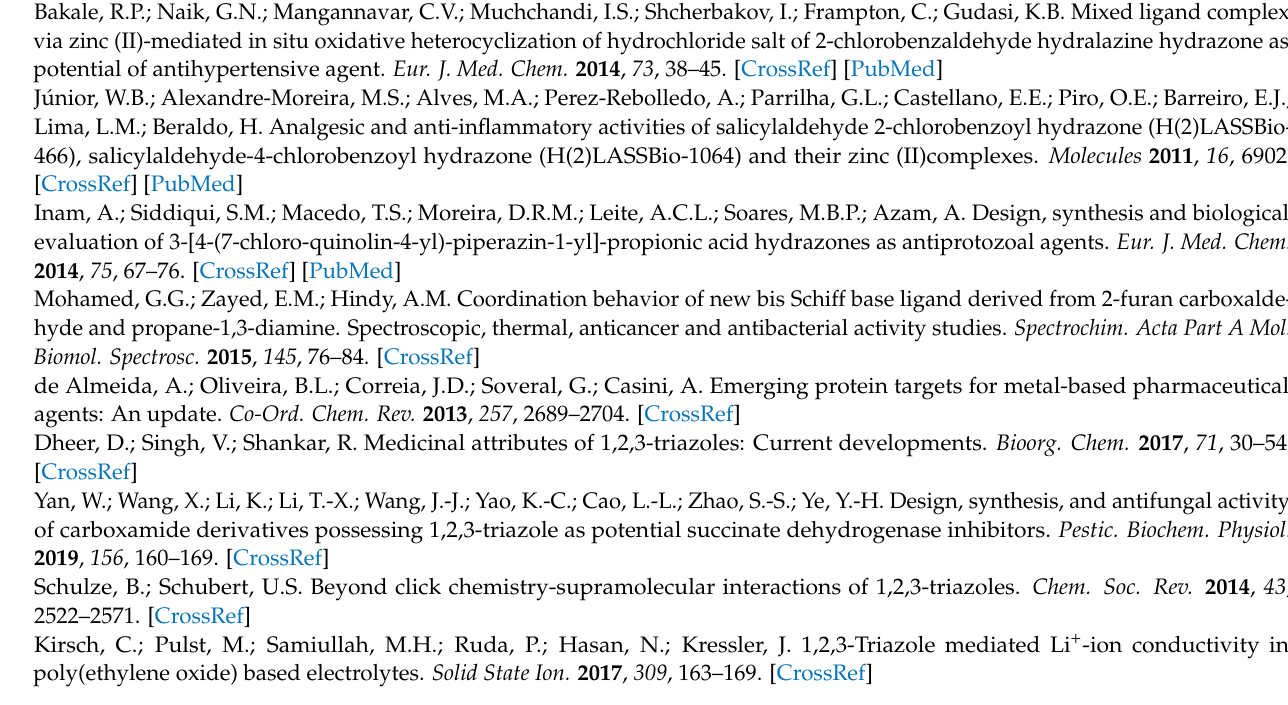
Figure S4: IR spectra of ligand and complex; Figure S5: UV-Vis of ligand and complexes; Figure S6: TGA/DTA thermogram; Figure S7: X-ray diffractograms of ligands and complex; Table S1: XRD data of ligand and